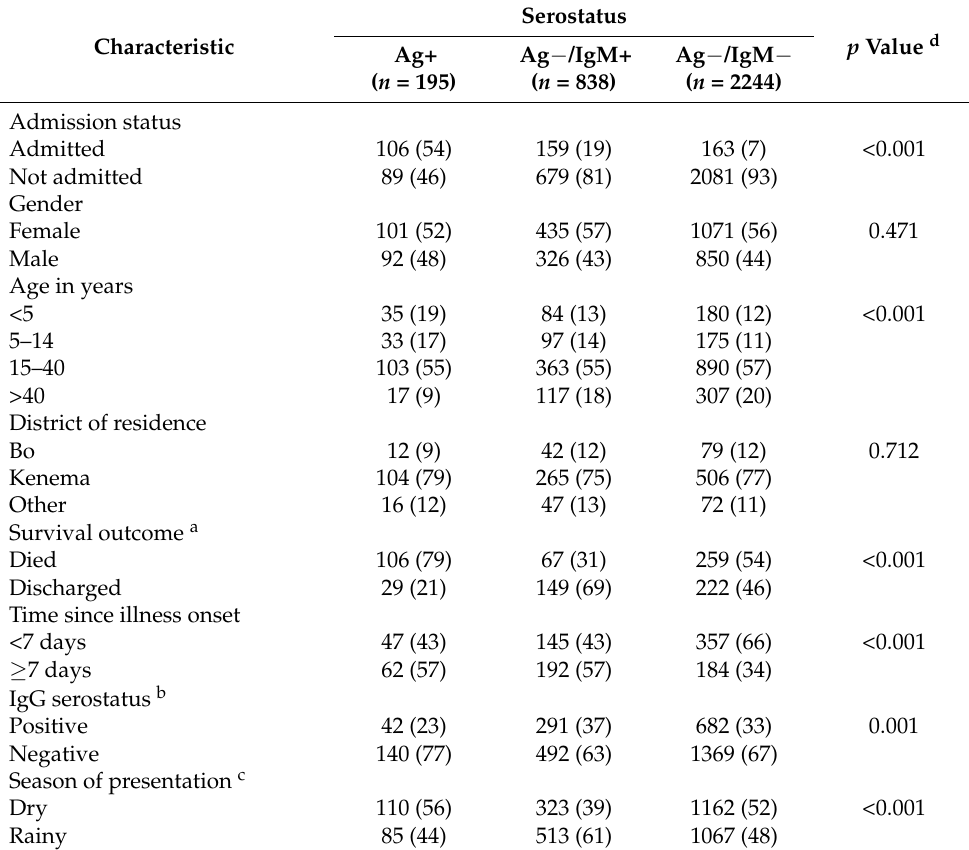
Table 1. Characteristics of Lassa fever screenings by serostatus, Kenema Government Hospital, 2012–2019. Note. All results expressed as frequencies and percentages unless indicated otherwise. Those characteristics with aggregate frequencies less than their respective aggregate serostatus group sample sizes reflect missing characteristic responses. Ag+ = Samples testing positive according to Ag ELISA (acute Lassa exposure); Ag − /IgM+ = Samples testing negative according to Ag ELISA and positive according to IgM ELISA (recent Lassa exposure); Ag − /IgM − = Samples testing negative according to both Ag and IgM